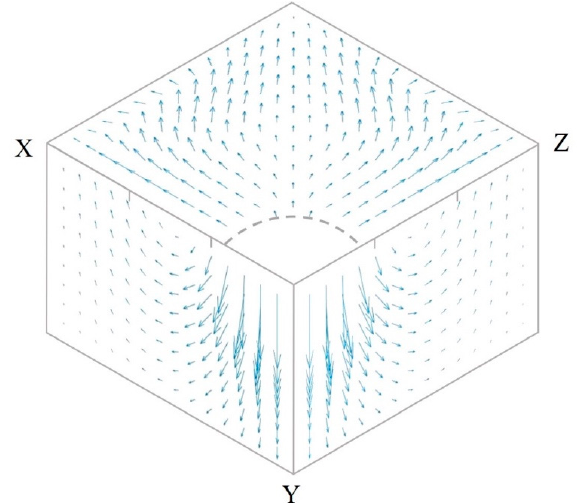
Figure 5. A vector plot of monodomain displacement m , for an isotropic tissue ( γ i = γ e = 0 ). The XZ plane is at Y = 1, XY plane is at Z = 0 plane, and YZ plane is at X = 0.